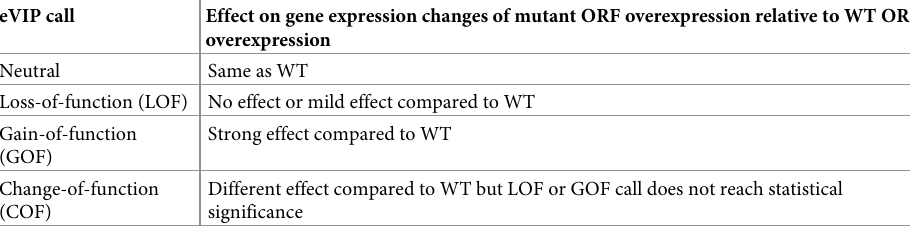
Table 1. Transcriptome-centric definitions of eVIP mutation impact